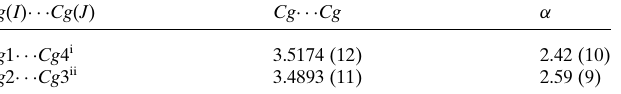
(Table 2) occur between the cyanurate rings of different units, having centroid–centroid distances of 3.5174 (12) and 3.4893 (11) A˚ , and two types of C—O (cid:2) (cid:2) (cid:2) (cid:4) interactions (Table 3) with different cyanurate rings with X (cid:2) (cid:2) (cid:2) Cg distances of 3.6086 (2) and 3.4783 (2) A ˚ are also present in the complex (Fig. 2). A packing diagram is presented in Fig. 3.